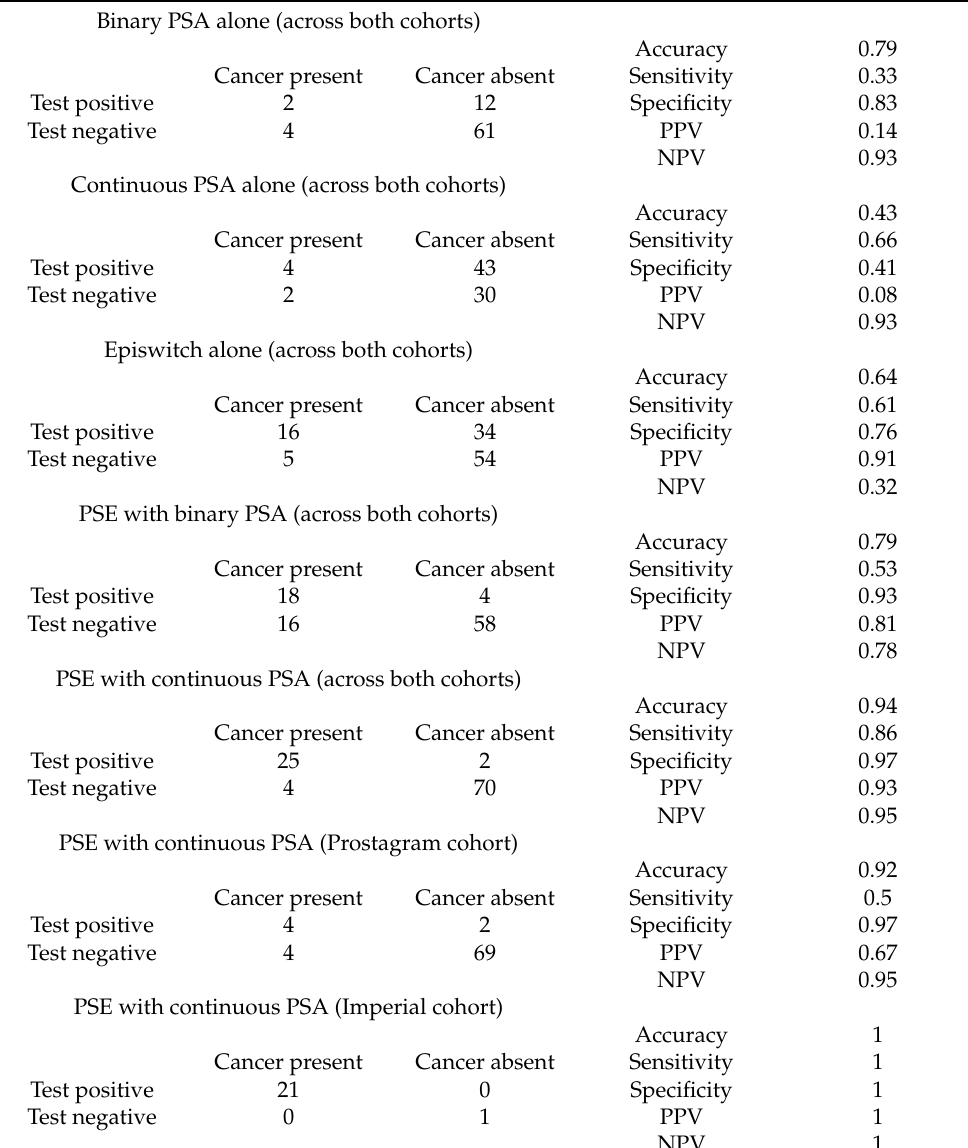
Table 3. Accuracy of various test modalities across both Imperial and PROSTAGRAM cohorts. Only final validation test (not training) results